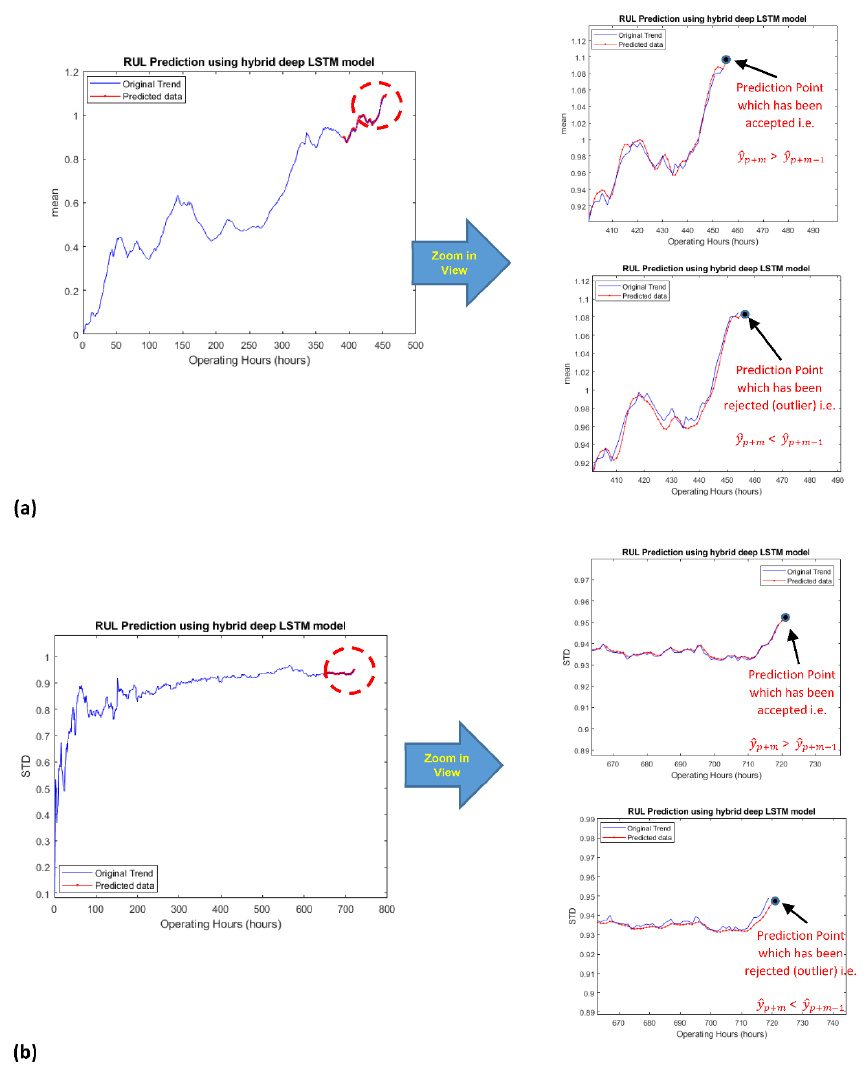
Figure 7. Accepted or rejected prediction point for becoming the part of the input vector for the next iteration in ( a ) channel 2 and in ( b ) channel 4.